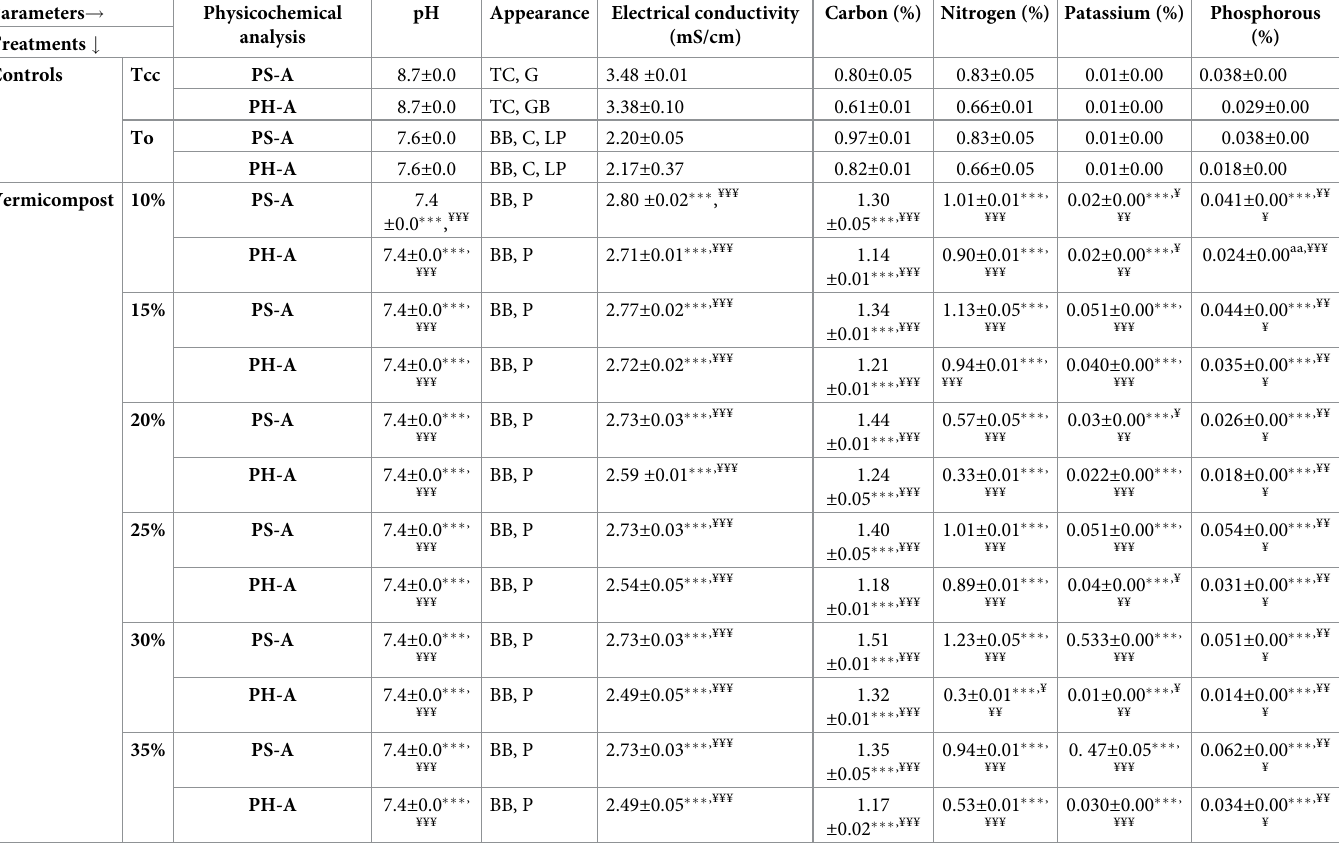
Table 1. Pre and post physicochemical examination of germinating media used for pansy seed germination and seedling.